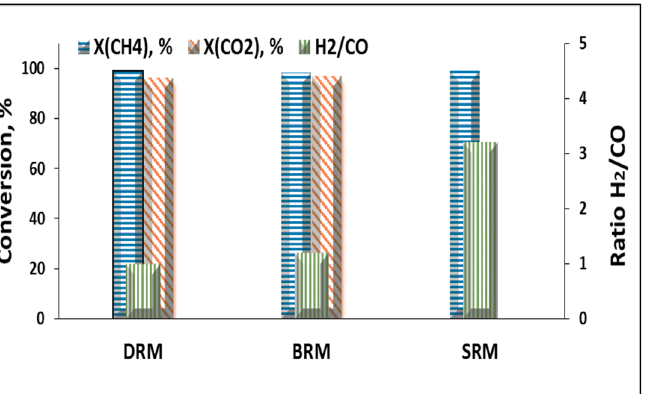
Figure 9. Comparative characteristics of methane conversion by dry (СН 4 /СО 2 = 1/1), bireforming (СН 4 /СО 2 /H 2 O = 1/1/1), and steam (СН 4 /H 2 O = 1/1) reforming over 5%Co-Rh(95:5)/Al 2 O 3 catalyst.at (CH 4 /CO 2 /H 2 O = 1/1/1), and steam (CH 4 /H 2 O = 1/1) reforming over 5%Co-Rh(95:5)/Al 2 O 3 t = 700 °C, Р = 1 atm, GHSV = 1000 h −1 . catalyst.at t = 700 ◦ C, P = 1 atm, GHSV = 1000 h − 1 .